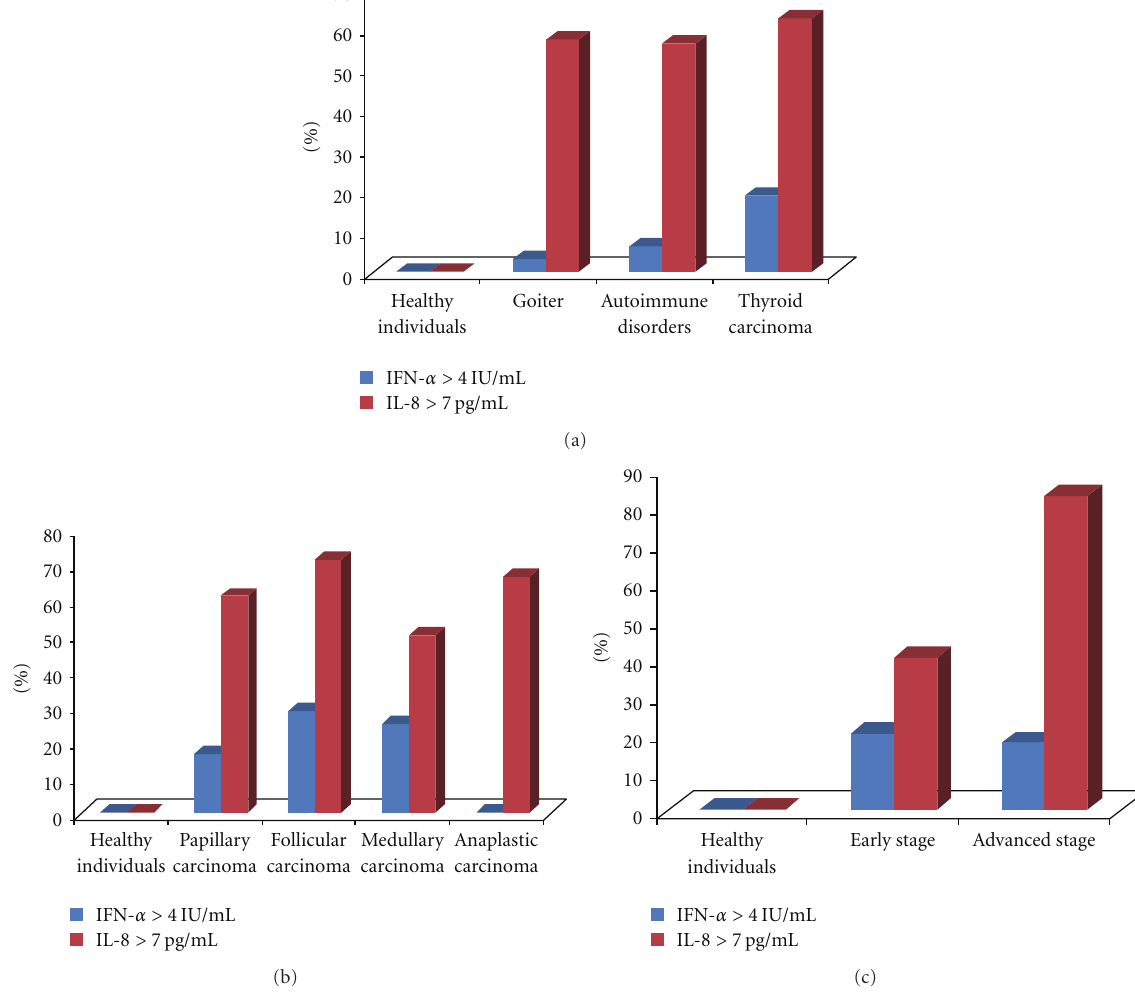
Figure 2: (a) Incidence of IL-8 and IFN- α levels in patients with thyroid diseases as compared to healthy individuals. (b) Incidence of IL-8 and IFN- α levels in thyroid carcinoma patients as compared to healthy individuals. (c) Incidence of IL-8 and IFN- α levels in early- and advanced-stage thyroid carcinoma patients as compared to healthy individuals.